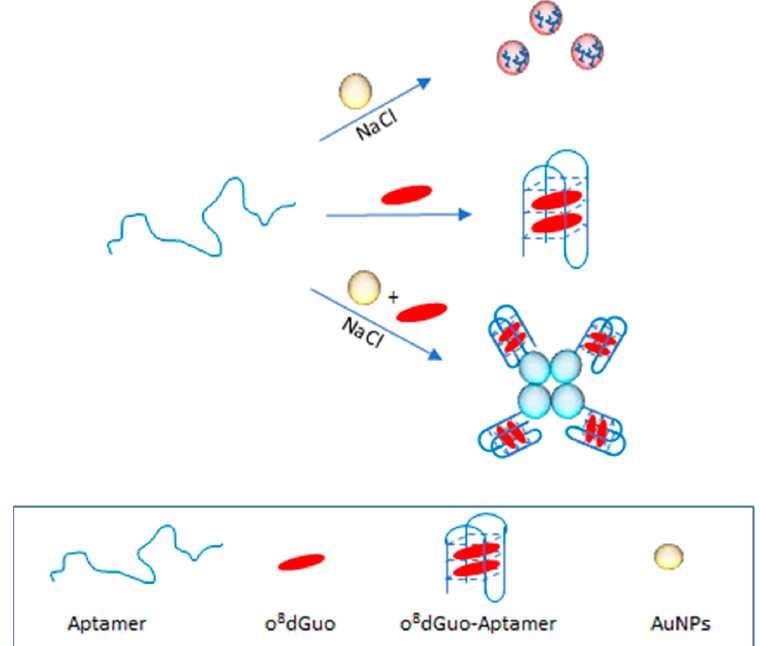
Figure 11. Gold nanoparticles used in the colorimetric determination of o 8 dGuo [38].